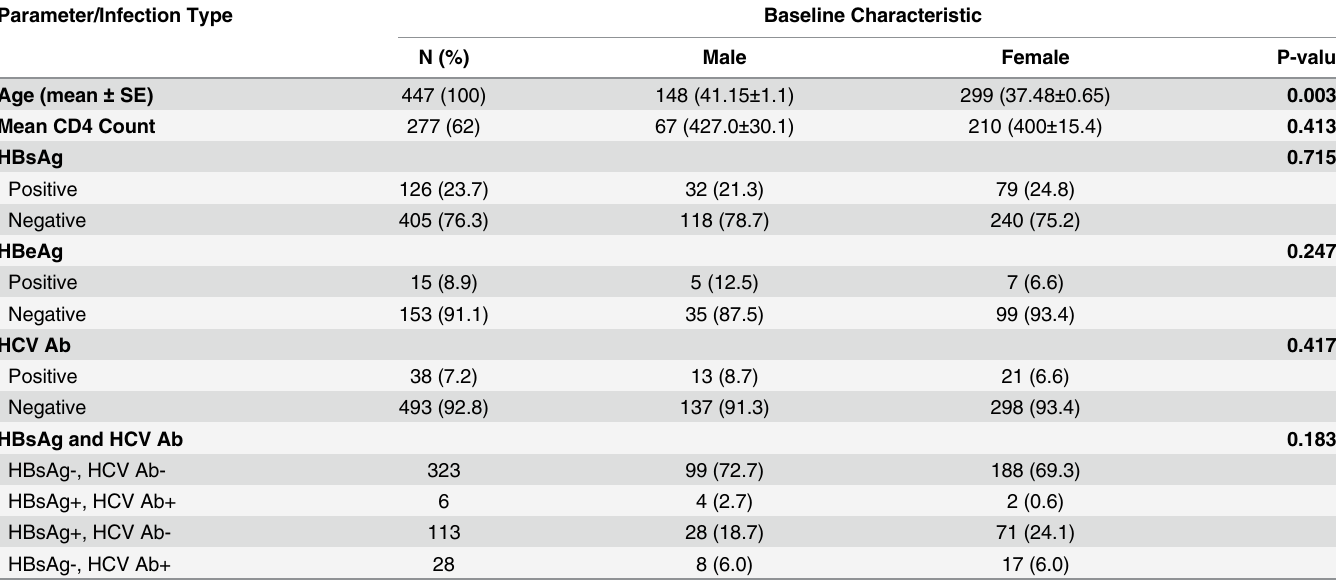
Table 2. Baseline characterization of HBV and HCV markers by